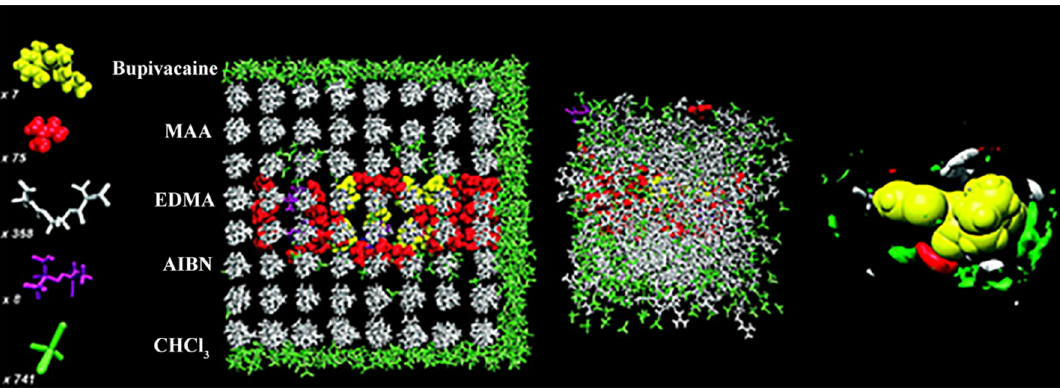
Figure 3. Schematic diagram of molecular dynamics calculation simulation molecular imprinting pre-assembly (Reprinted with permission from [85]. Copyright 2009 American Chemical Society).